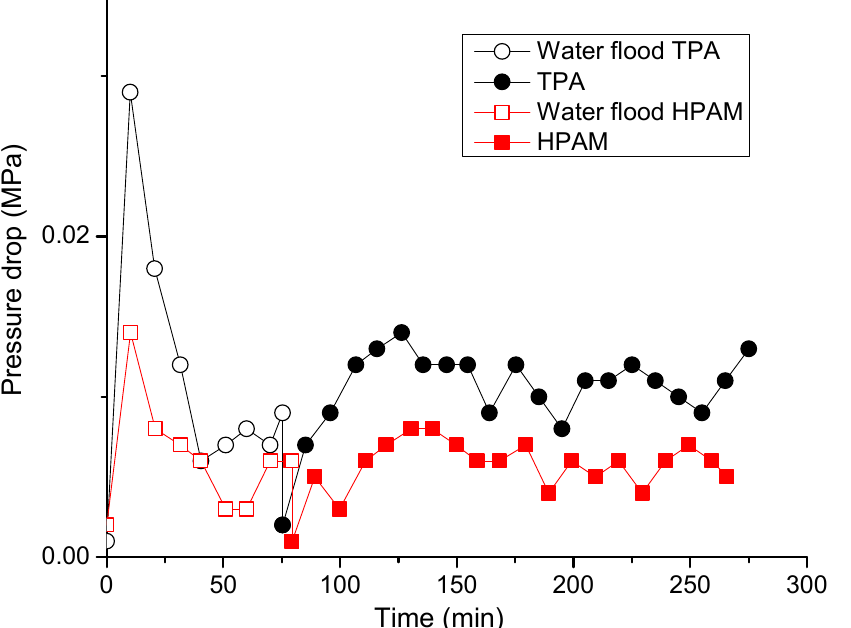
Figure 13. Pressure drop values registered during the water and polymer flooding experiments, using 5 cm-long sand packs and 0.25 wt.% TPA and HPAM solutions in 200 g ∙ L − 1 brine.